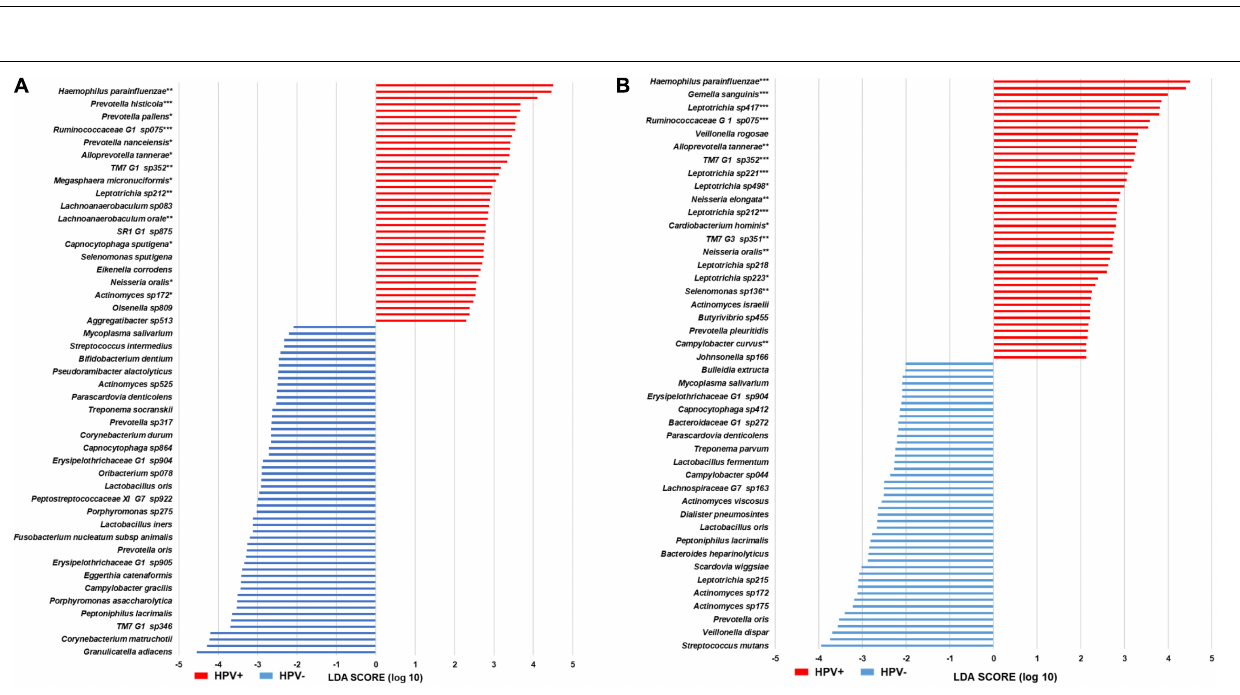
FIGURE 2 | PERMANOVA results comparisons flowchart. (A) Grp-All. (B) Grp-noAB. β -diversity analyses were performed using PERMANOVA in PRIMER v7 software (PRIMER-E Ltd., IvyBridge, United Kingdom) to compare microbial profiles of head and neck cancer (HNC) patients to healthy controls (HC) and to compare microbial profiles of HNC HPV-positive (HPV+) patients to HNC HPV– patients. Sample sites consisted of three to four site combinations of buccal (B), plaque (P), saliva (S), and tongue (T). PERMANOVA analysis was completed using two different analytical designs based on Bray–Curtis similarity matrices determined from square root transformed relative abundance data of 737 probes (620 species and 117 genus probes). Sample site combinations consisted of BPST, BST, and PST for (A) Grp-All HNC vs. HC ( N = 30; N = 20) and (B) Grp-no Antibiotics (Grp-noAB) HNC vs. HC ( N = 19; N = 20). a For the Grp-All HNC vs. HC comparison, “Diagnosis” was the main fixed factor, and “Sample Site” was the secondary fixed factor. “Antibiotics” was nested into “Diagnosis” and “Sample site” factors as a random variable. Grp-noAB analytical design did not include antibiotics as a factor. b For the analytical design considering HPV, “HPV status” and “Sample site” were set as fixed factors and “Antibiotics” as nested as random factor. Grp-noAB analytical design did not include antibiotics as a factor. Level of significance is denoted using an asterisk (*): * < 0.05 = p -value less than 0.05; ** < 0.01 = p -value less than 0.01; *** < 0.001 = p -value less than 0.001.